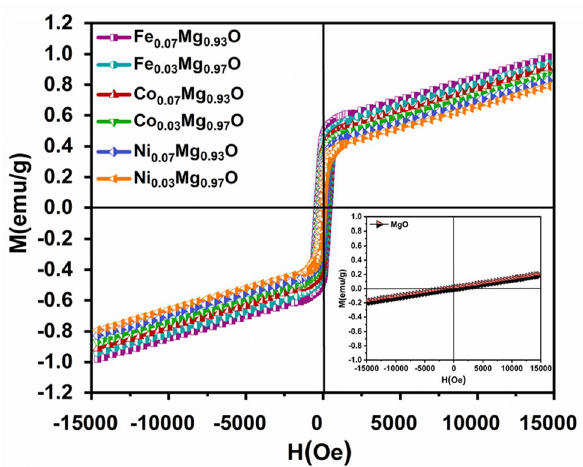
Figure 11. Magnetization hysteresis (M-H) curve of (Ni x , Co x , Fe x ) Mg 1−x O (x = 0.0, 0.03, and 0.07) nanoparticles measured at RT.